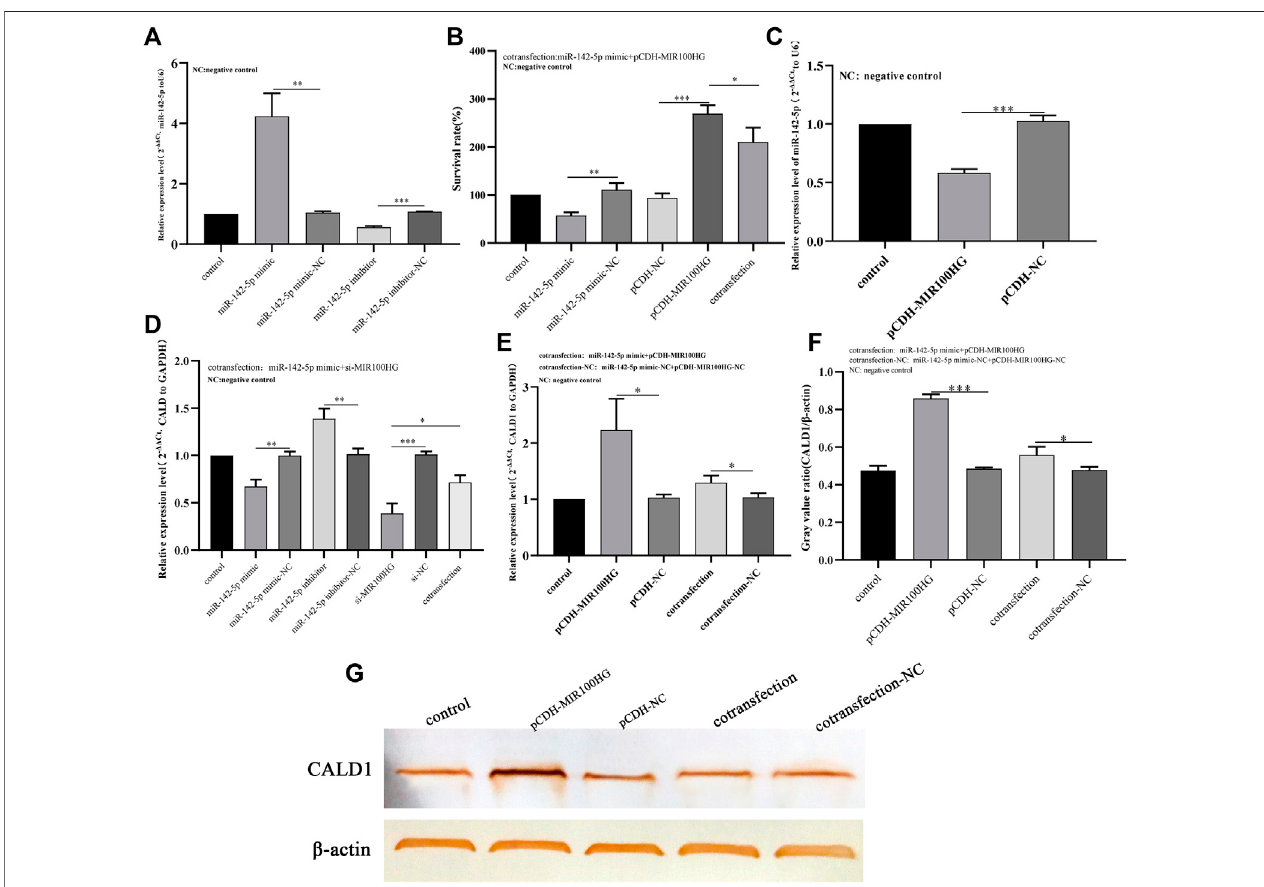
FIGURE 9 |(A) Analysis ofthe effects ofmiR-142-5p knockdown or overexpression in 5,637 cells using qPCR. The expression level ofU6 was used as an internal reference. (B) The effect of miR-142-5p interference with MIR100HG on the proliferation of 5,637 cells using CCK8 assay. (C) Analysis of effect of MIR100HG overexpressiononendogenousmiR-142-5p expressionin5,637cellsusingqPCR.TheexpressionlevelofU6wasusedasaninternalreference. (D) Analysisofeffectof miR-142-5p interference with MIR100HG on CALD1 expression in 5,637 cells using qPCR. The expression level of GAPDH was used as an internal reference. (E) Analysis of effect of miR-142-5p targeted by MIR100HG on CALD1 expression level in 5,637 cells using qPCR. The expression level of GAPDH was used as an internal reference. (F,G) AnalysisofeffectofmiR-142-5ptargetedbyMIR100HGonCALD1proteinlevelin5,637cellsusingwesternblot.Theproteinlevelof β -actinwasusedas an internal reference. NC stands for negative control. pCDH-NC represents negative plasmid of pCDH- vector, and has no effect on cell biological function after transfection. Si-NC represents the negative control of si-RNA, which has no effect on cell biological function after transfection. “ Control ” refers to the cell group without any plasmid transfection, which is only used as a reference for the analysis of the experimental group. The data are shown as the mean ± standard deviation. Cotransfection:Thetwotargetplasmidsweretransferredintocellsatthesametime.Cotransfection-NC:Thenegativecontrolofthetwotargetplasmidsweretransferred into the cells at the same time. “ *** ” p -value < 0.001, ” ** ” p -value < 0.01, ” * ” p -value <